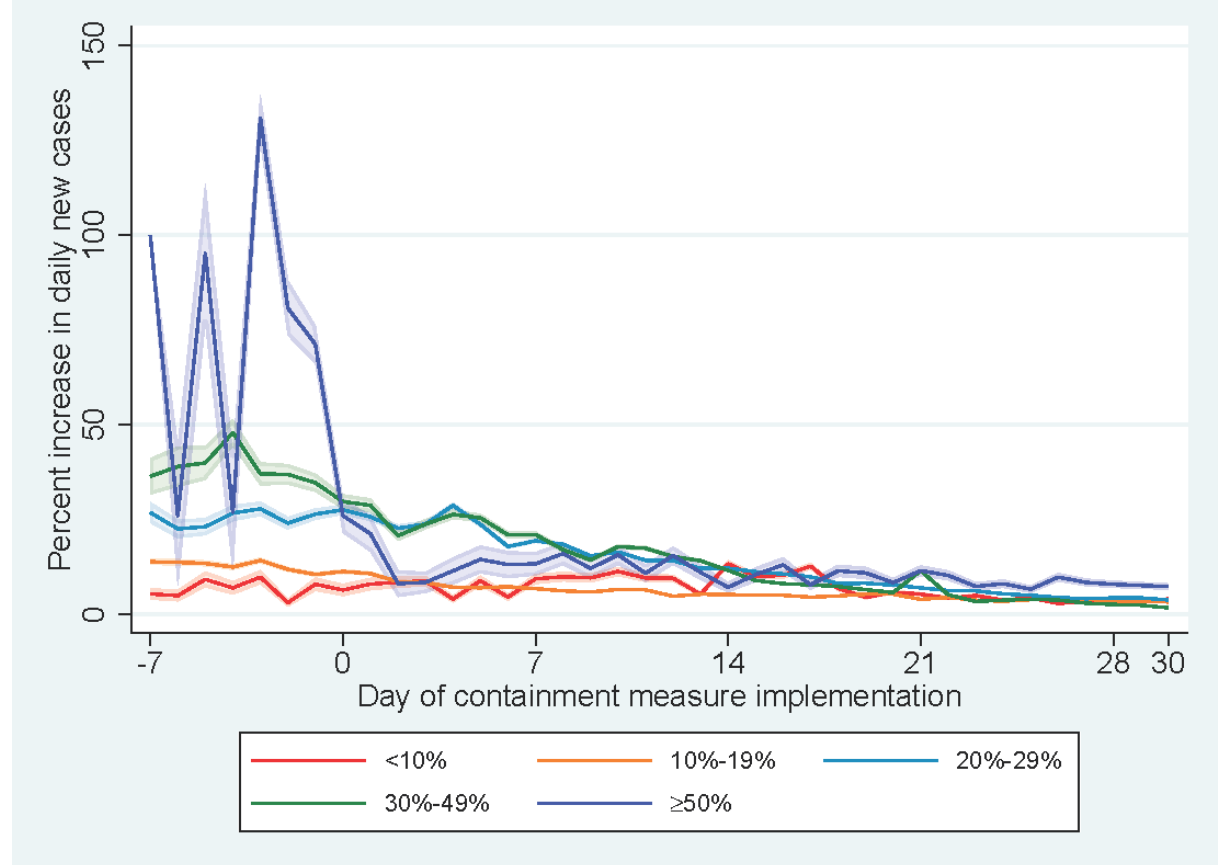
Figure 5. Percent increases in daily new cases vs days since implementation of containment measures by average percent increase in daily new cases before the containment